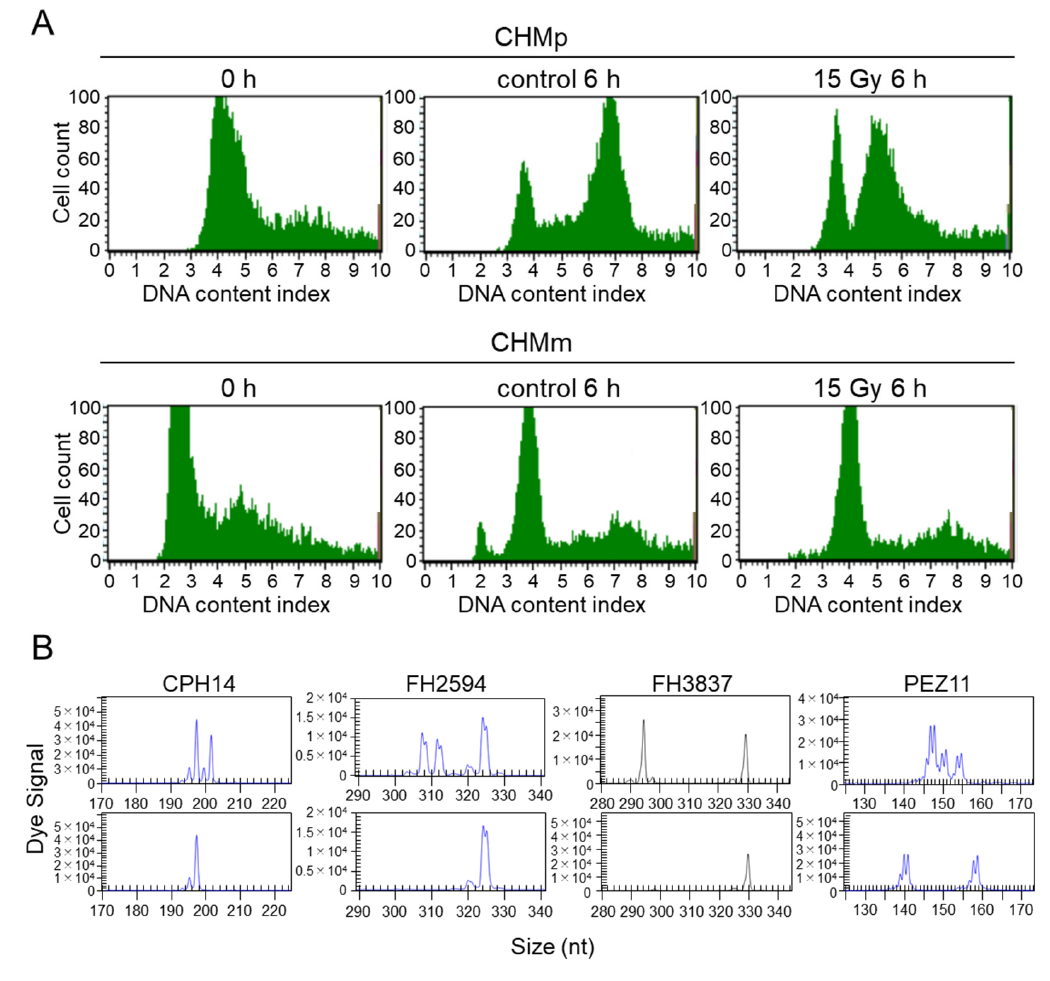
Figure 5. Cell cycle profile after irradiation and microsatellite profile of CHMp and CHMm. ( A ) FACS analysis using PI staining was performed after 15 Gy irradiation. ( B ) Microsatellite analysis of cell lines established from the same origins. Thirteen microsatellite loci were compared between CHMp (upper panel) and CHMm (lower panel) cells. Four loci (CPH14, FH2594, FH3837, and PEZ11) were different, but the other nine loci shown under the panels were identical between these two cell lines.